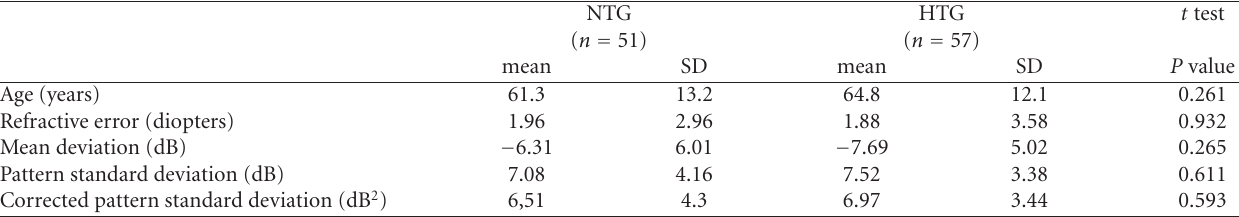
Table 1: Descriptive analysis in high-tension glaucoma (HTG) and normal-tension glaucoma